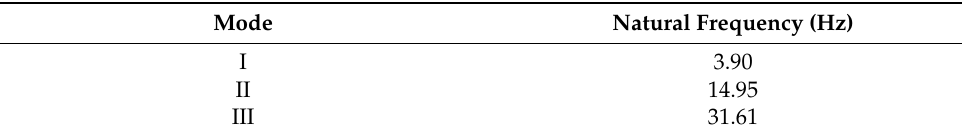
Table 2. Fundamental natural frequencies of the beam.